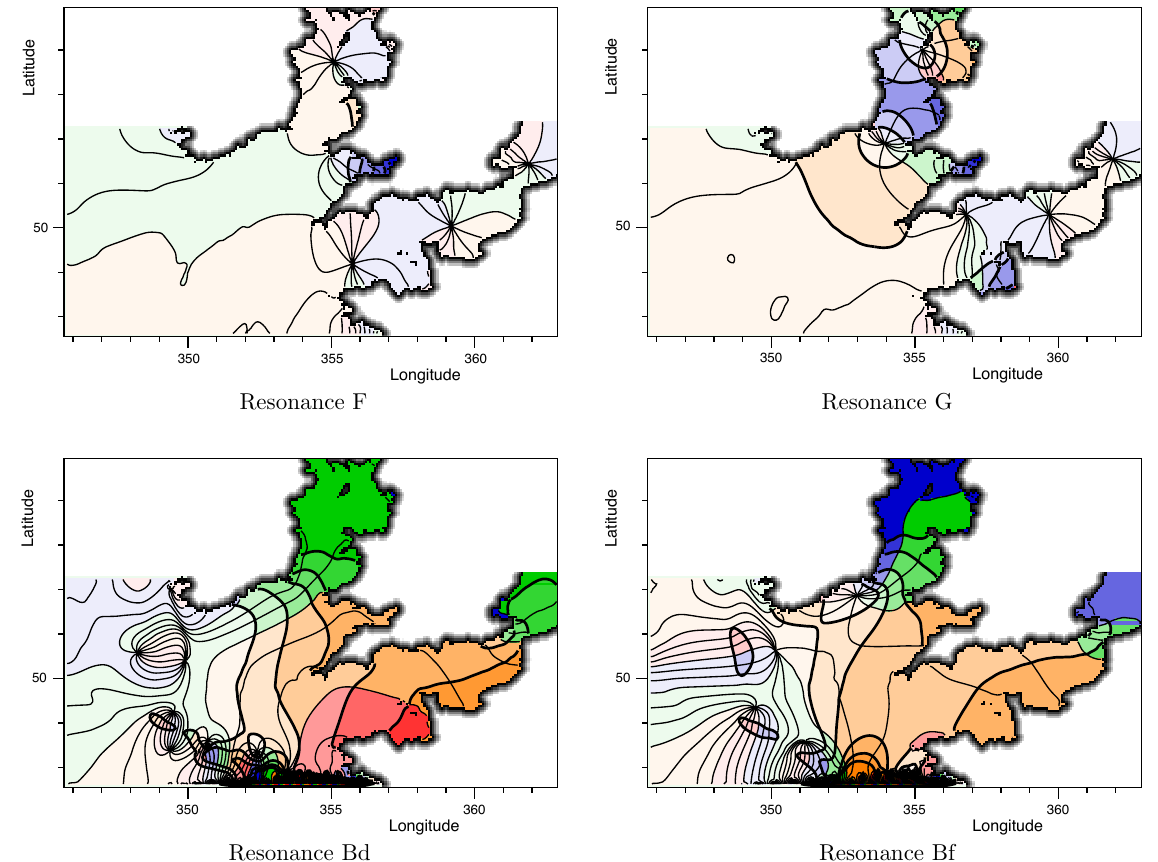
Fig. 9. Amplitude and phase of the resonances F, G, Bd and Bf (table 3). Colours as in Fig. 8. F and G normalized so that the maximum amplitude is 1. Bd and Bf normalized to show the small amplitude structure on the continental